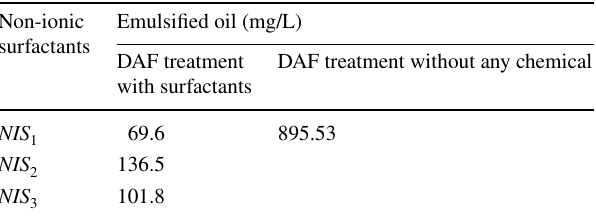
Table 3 The density and solubility in water of the first four compounds and normal alkanes with the same number of carbon atoms